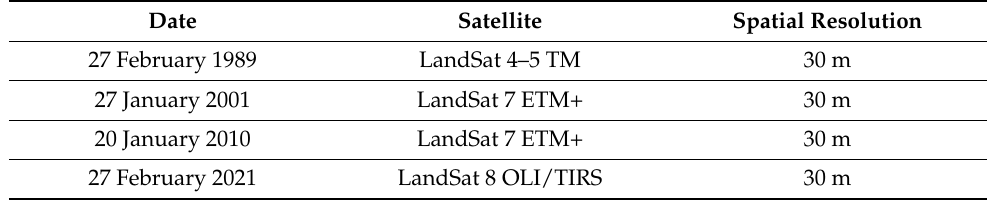
Table 1. Details of acquired images.